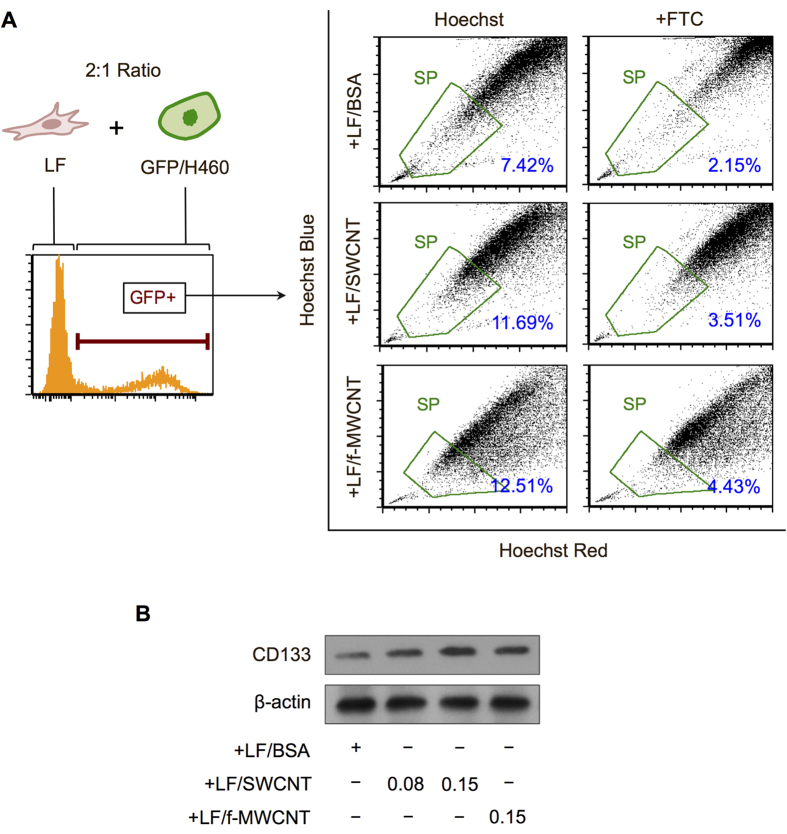
Analysis of side population and lung stem cell marker CD133 in lung carcinoma cells cultured with carbon nanotube-induced cancer-associated fibroblast-like cells.Carbon nanotube-induced cancer-associated fibroblast-like cells (LF/SWCNT or LF/f-MWCNT) or vehicle-treated fibroblasts (LF/BSA) were co-cultured with GFP-labeled lung cancer H460 cells (2:1 ratio). (A) Analysis of side population (SP) of the GFP-labeled H460 cells in the presence or absence of fumitremorgin c (FTC) using FACS. SP cells (box) are determined by their disappearance in the presence of FTC. (B) Western blot analysis of lung stem cell marker CD133 in the co-culture of H460 cells with LF/BSA, LF/SWCNT or LF/f-MWCNT cells.